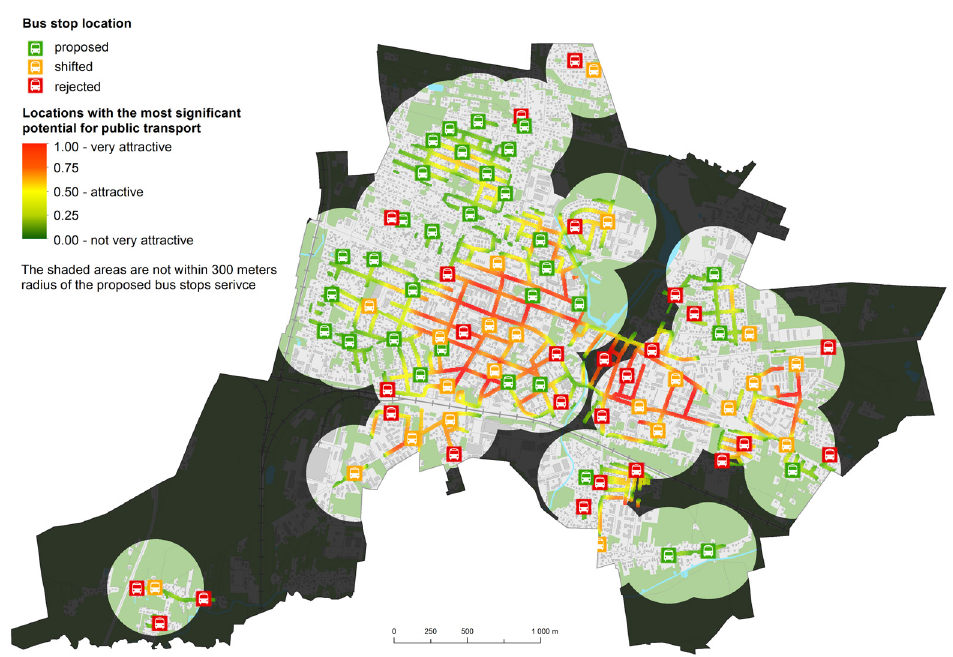
Fig. 10. Locations with the most significant potential for public transport with results of the stop location